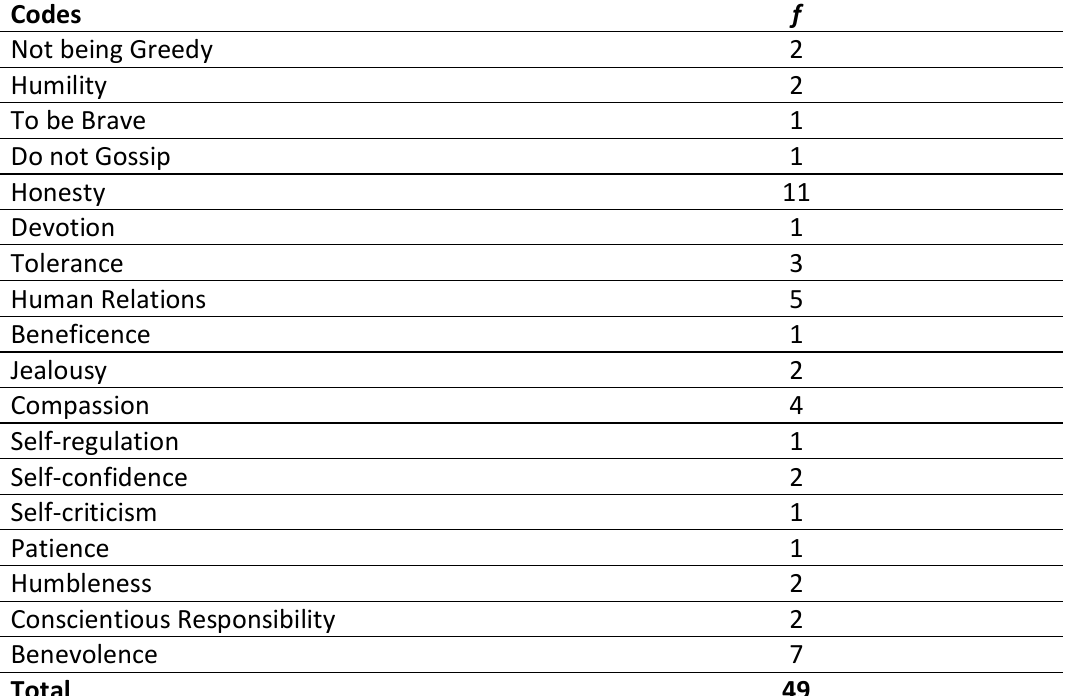
Table 7. Codes and Statistics of Moral Values Theme